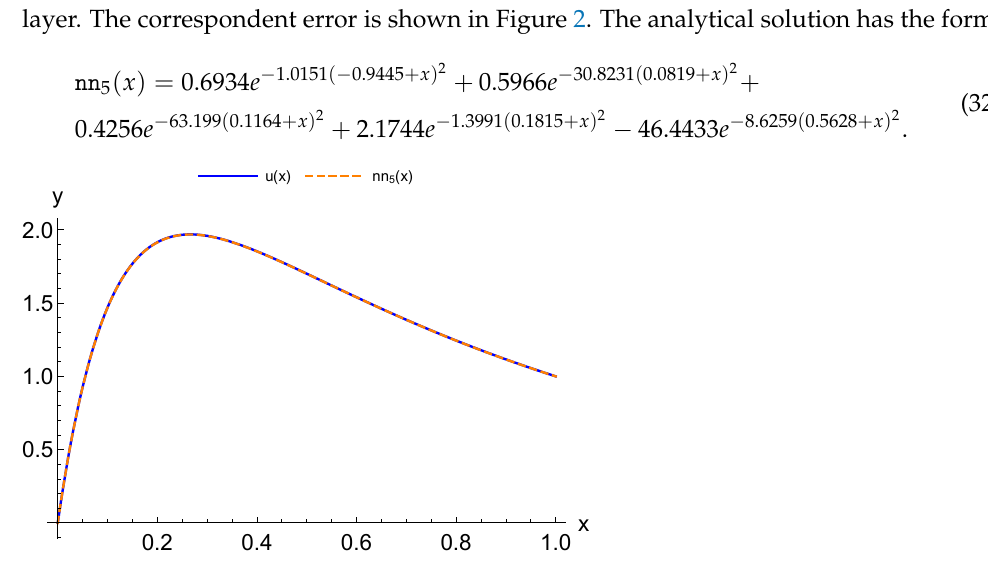
Figure 1. Plots of neural network solution nn 5 ( x ) (9) (number of layers n = 5; Gaussian activa- tion functions) as applied to problem (30) and its exact solution u ( x ) (parameter value s = 0.1), corresponding to dashed and solid lines,